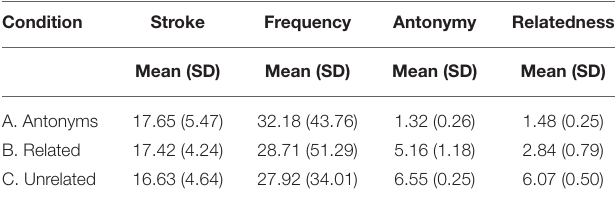
TABLE 1 | Mean rating scores in both